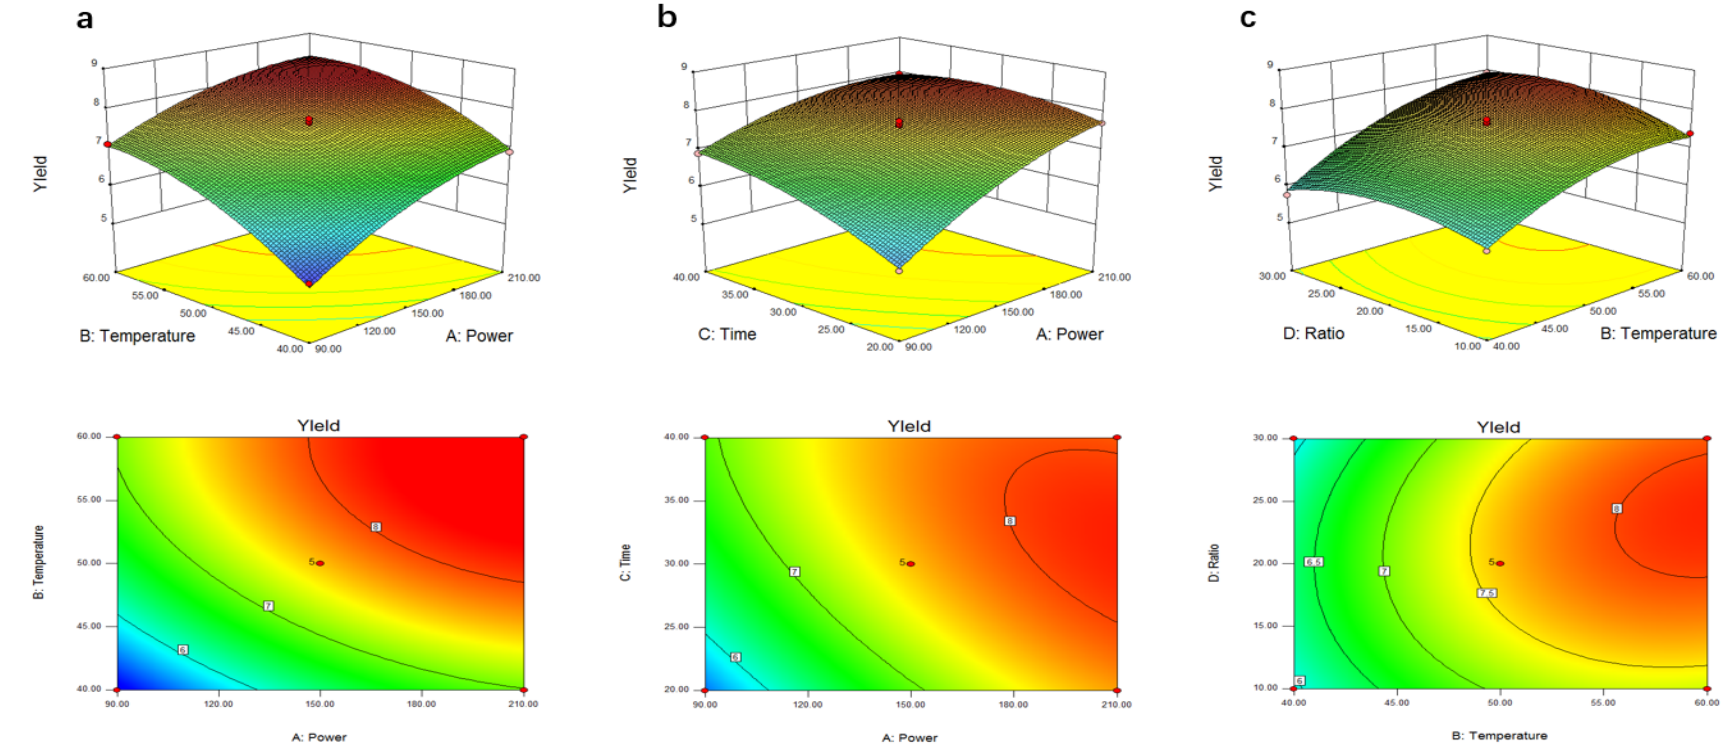
Figure 2. Response surface plots showing effects of ultrasound power ( a ), extraction temperature ( b ), extraction time and Ratio of liquid to raw material ( c ) on the yield of UAE ‐ VVP.